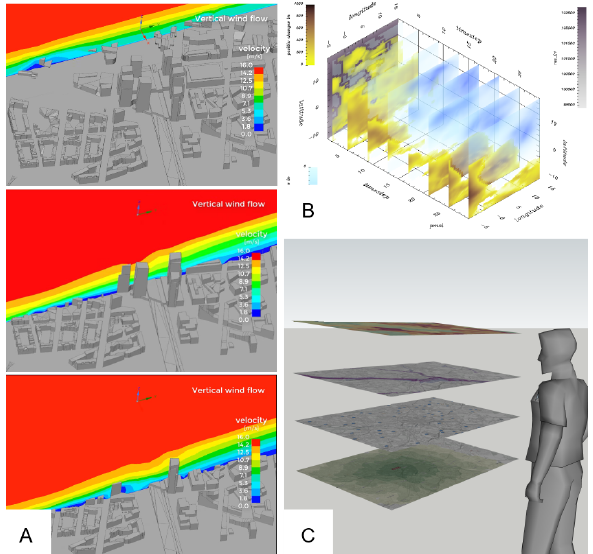
Figure 2. Using one or several 2D planes to represent 3D scalar data; (A) Wind speed data rendered on a spatially animated 2D vertical section (Image from the Kalasatama Digital Twins Project, City of Helsinki 3 ); (B) Using 3D space-time cube to represent 2D raster data at different timesteps (Aigner et al., 2011); (C) Using 3D stack of 2D planes to represent several thematic data. (Spur, Tourre,